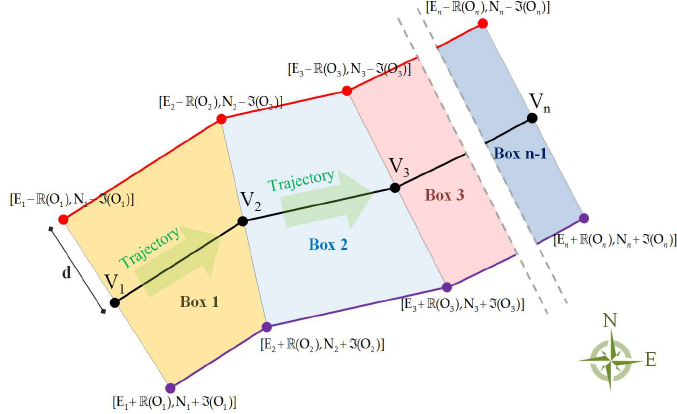
Figure 5. Scheme of the construction of the boxes, used to cut the point cloud in sub-clouds.